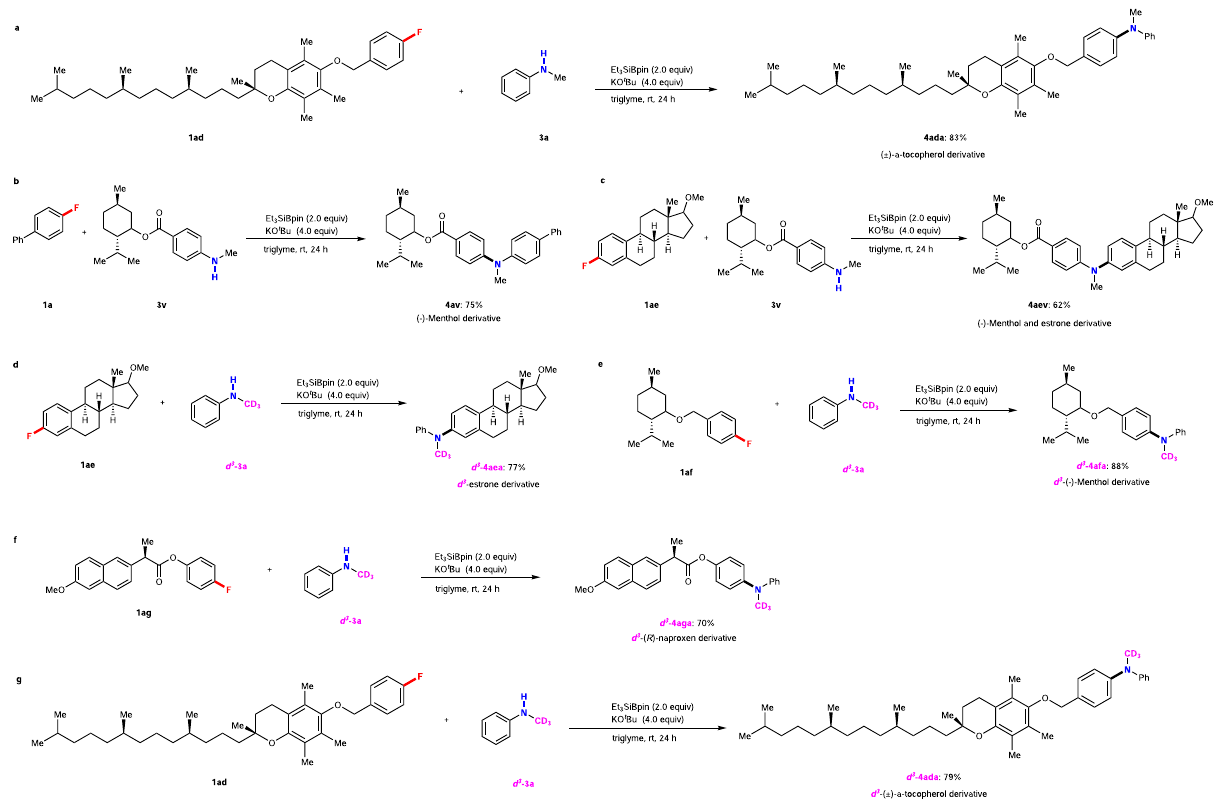
Fig. 3 | Synthetic applications. a – c Late-stage cross-coupling aminations of pharmaceutically attractive molecules. d – g Late-stage syntheses of pharmaceutically attractive molecules containing deuterated N -methyl